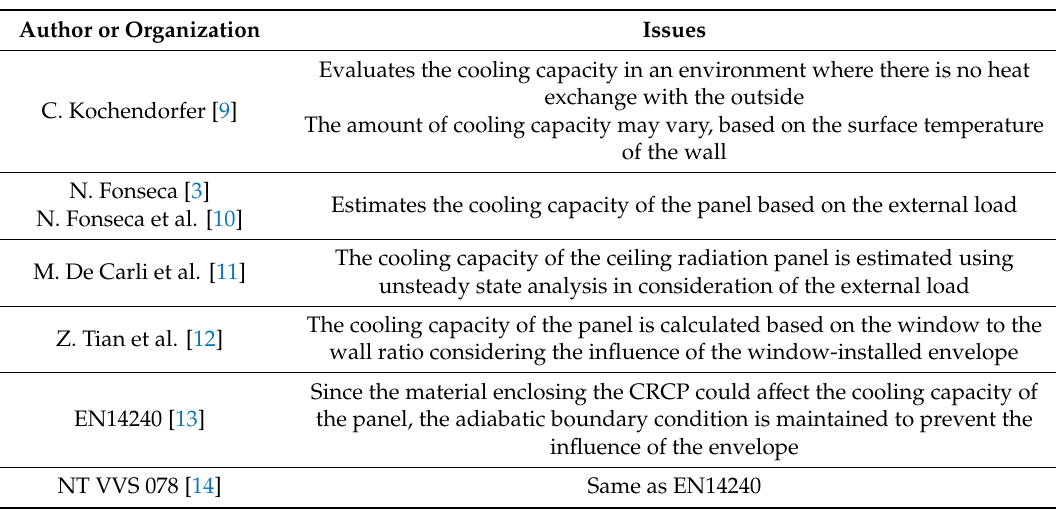
Table 3. Previous studies on irregular surrounding